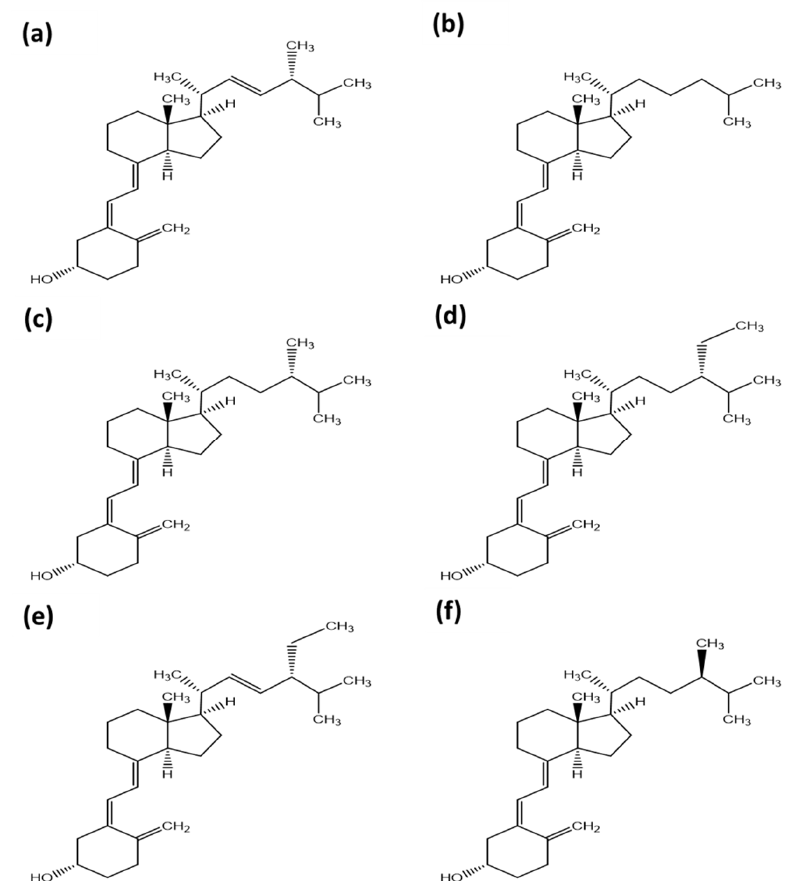
Figure 2. Isoforms of vitamin D: ( a ) Ergocalciferol or vitamin D 2 ; ( b ) cholecalciferol or vitamin D 3 ; ( c ) 22-dihydroergocalciferol or vitamin D 4 ; ( d ) sitocalciferol or vitamin D 5 ; ( e ) vitamin D 6 ; ( f ) vitamin D 7 .